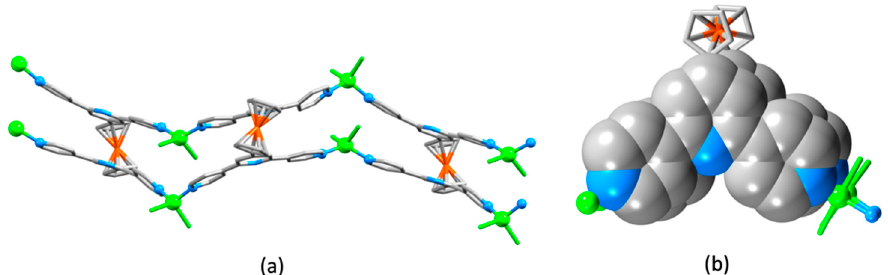
Figure 38. ( a ) Part of 1D-coordination polymer in [ZnCl 2 ( 58 )] n · 3 n CHCl 3 and ( b ) π -stacking Figure 38. (a) Part of 1D ‐ coordination polymer in [ZnCl 2 ( 58 )] n . 3 n CHCl 3 and (b) π‐ stacking between 4,2 ′ :6 ′ ,4 ″‐ tpy units in the coordinated ligand 58 (CSD refcode UMUYUY).